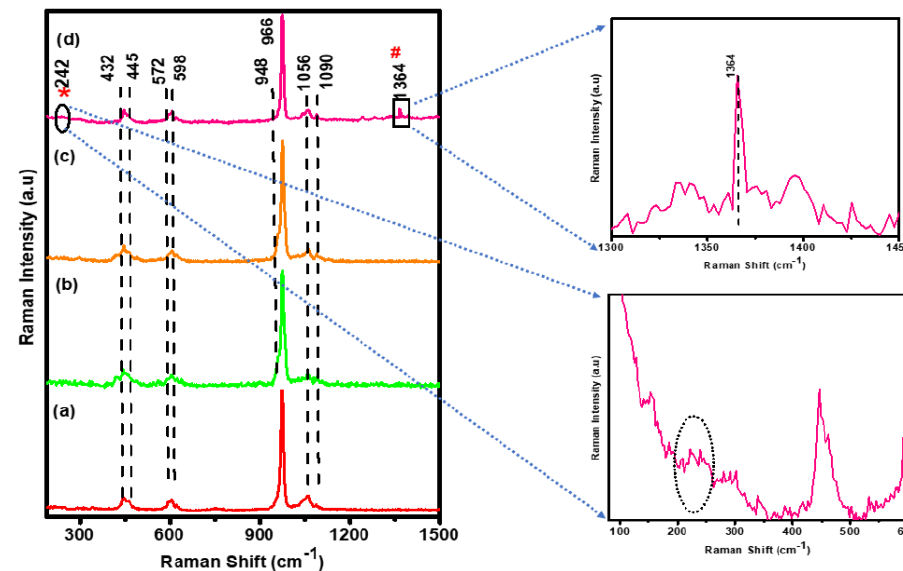
Figure 2. Comparison of the Raman spectra of ( a ) HAP, ( b ) β -TCP, ( c ) BCP, and ( d ) Ag-BCP samples. Table 2. Raman spectral data of (a) HAP, (b) β -TCP, (c) BCP, and (d) Ag-BCP. 284 Frequency of Vibration (cm − 1